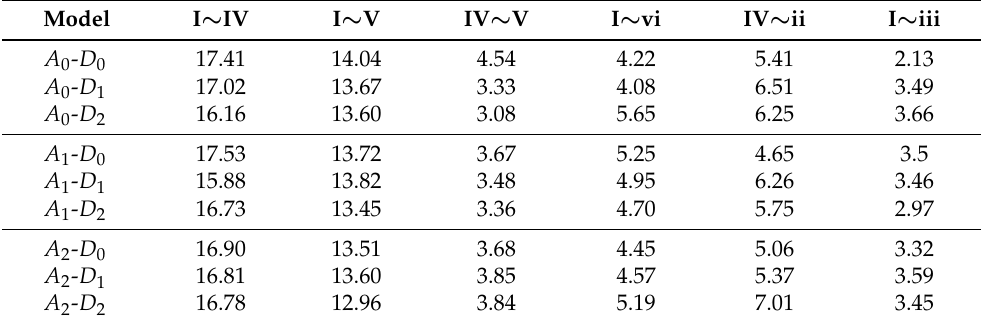
Table 5. Errors (>2%) corresponding to degrees substitutions (% of the total number of errors on diatonic targets). In this table, columns I ∼ IV correspond to totals of the errors that satisfy: I substituted to IV or IV substituted to